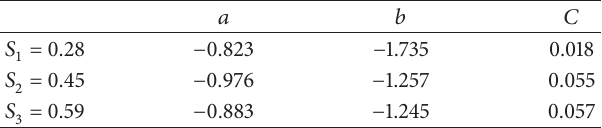
Table 3: Coefficients of the regression lines of 𝛽 1 , 𝛽 2 , and 𝛽 3